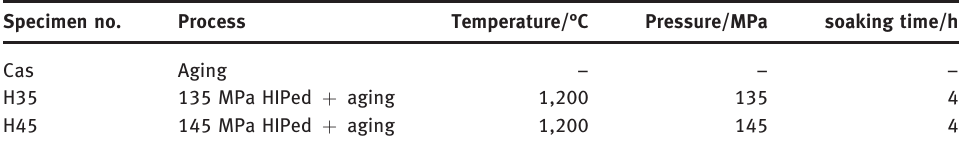
Table 2: The HIP conditions of three groups of specimens. Specimen